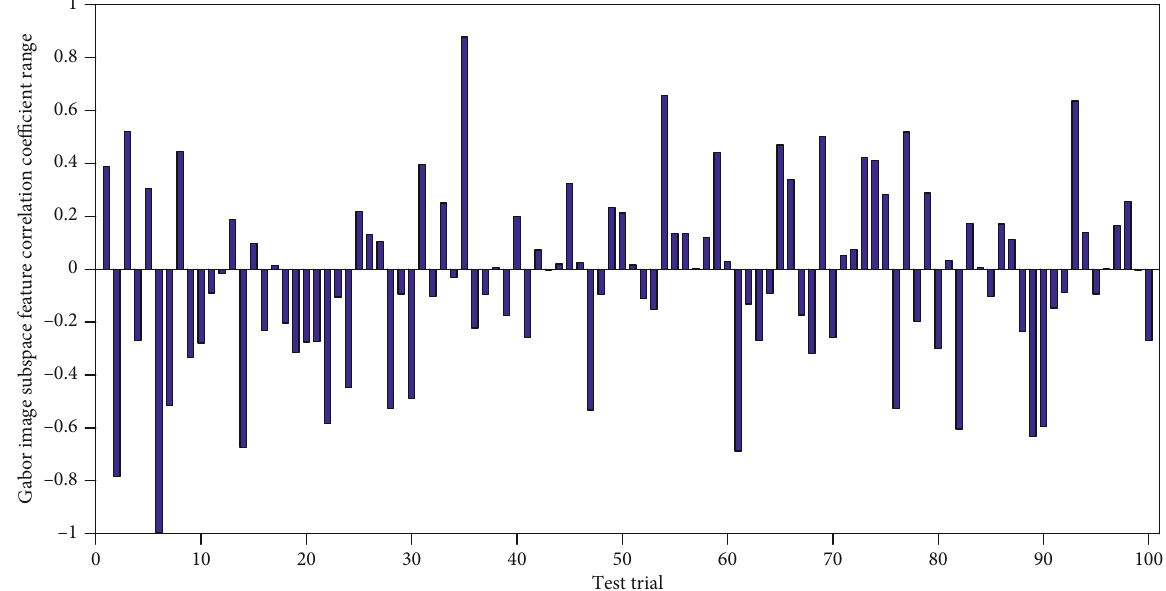
Figure 4: Gabor image subspace feature correlation coe ffi cient